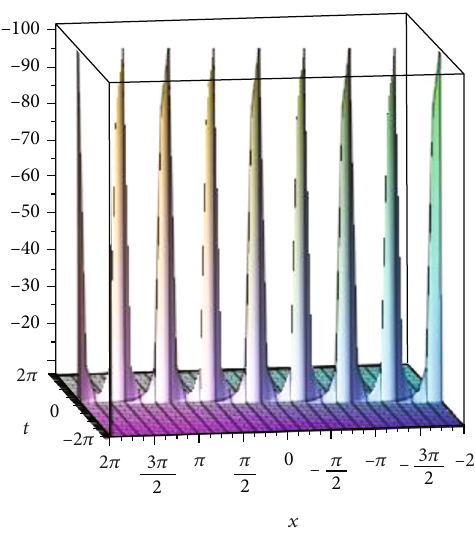
ð z Þ for the fi xed s ,2